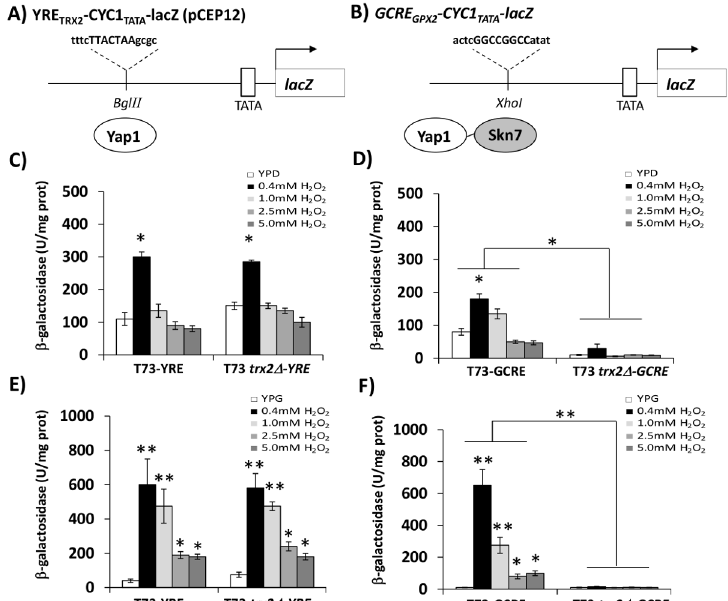
Figure 3. Promoter regulation by the Yap1p and Skn7p transcriptional factors in strains T73 and T73 trx2∆ . (A) The cells carrying the depicted modification of the TRX2 promoter fused to the LacZ vector construction (T73-YRE and T73 trx2∆ -YRE) for Yap1p recognition or (B) the cells carrying the depicted modification of the GPX2 promoter fused to the LacZ vector construction (T73-GCRE and T73 trx2∆ -GCRE) for Yap1p-Skn7p recognition were cultured in YPD (C, D) or YPG medium (E, F) until the mid-log phase and were treated with different H O concentrations (0.4, 1, 2.5 and 5 mM) for 60 min. Experiments were carried out using 2 2 three biological replicates and the error bars corresponding to SD are shown. Statistical analyses were performed using a Student´s t -test between samples in the same growth media, YPD or YPG (* p< 0.05, ** p< 0.01). doi: